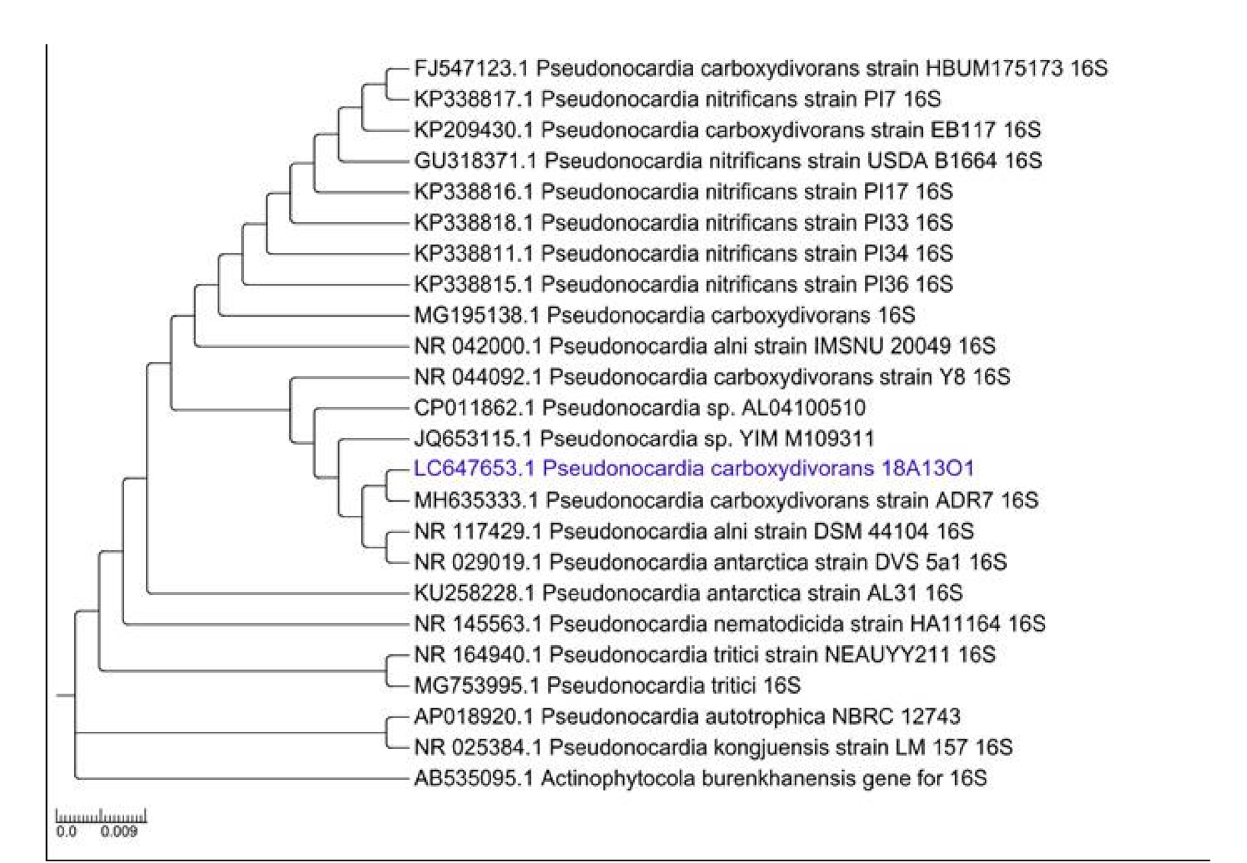
Figure 4. Phylogenetic tree using maximum likelihood method and Tamura 3-parameter model of 22 Pseudonocardia representatives and Actinophytocola burenkhanensis (Acc. No. AB535095) as an outgroup. Bootstrap values (1000 resamples) are given in percent at the nodes of the tree. The isolate P. carboxydivorans 18A03O1 is presented in